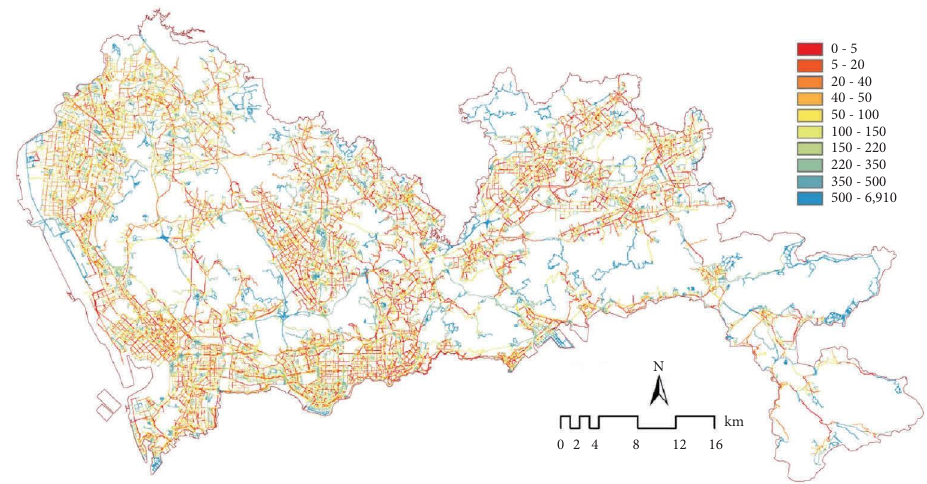
Figure 3: Distance from bus station.